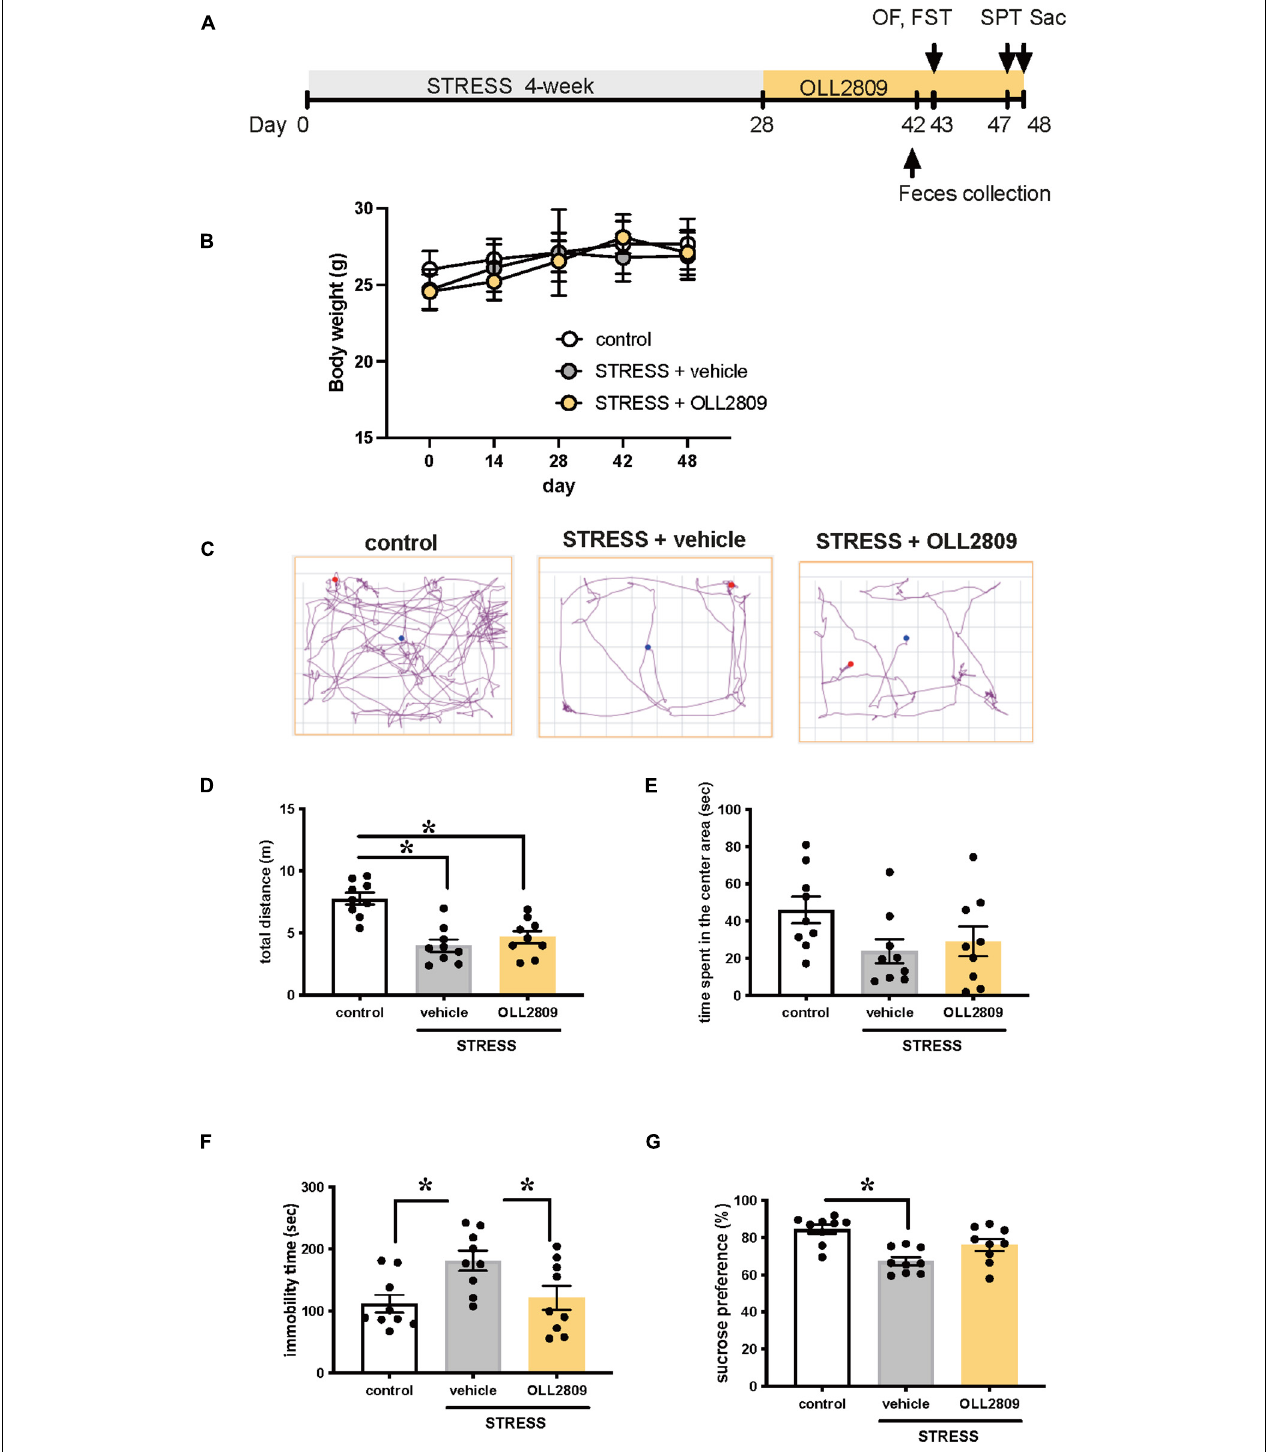
FIGURE 1 | Lactobacillus paragasseri OLL2809 rescues depression-like behavior. (A) Outline of the experimental protocol. (B) Body weight. (C) Representative motion tracks for control, stress + vehicle and stress + OLL2809 groups in the open field test. (D) Locomotion: total distance travel in the open field test. (E) Time spent in the center area in the open field test. (F) Immobility times in the forced swim test. (G) The percentage of sucrose preference in the sucrose preference test. Each bar indicates the mean ± S.E.M. * p < 0.05, Tukey–Kramer test. Each plot represents the number of individual mice. Control, n = 9; stress + vehicle, n = 9; stress + OLL2809, n = 9; OF, open field test; FST, forced swim test; SPT, sucrose preference test; Sac, sacrificed.